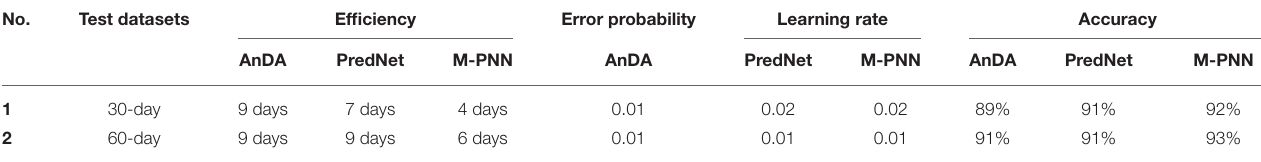
TABLE 3 | The comparison of efficiency, error probability, accuracy, and learning rate of the three data-driven methods. No.